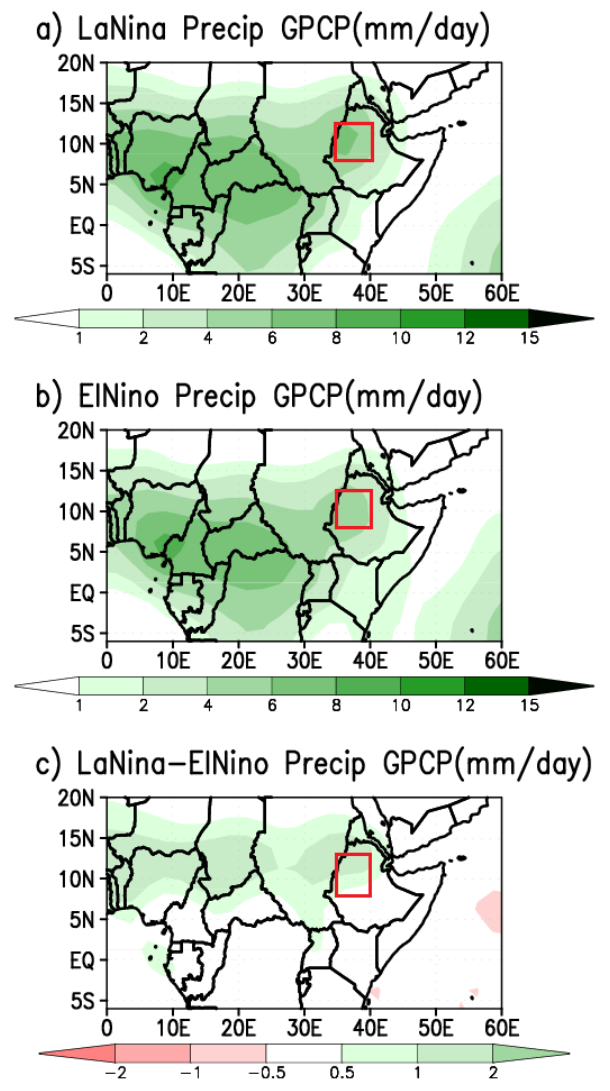
Figure 7. GPCP rainfall during JJAS for (a) 5 La Niña years (1988, 1998, 1999, 2007 and 2008), (b) 5 El Niño years (1982, 1983, 1987, 1992 and 2002), and (c) the difference between La Niña years and El Niño years.